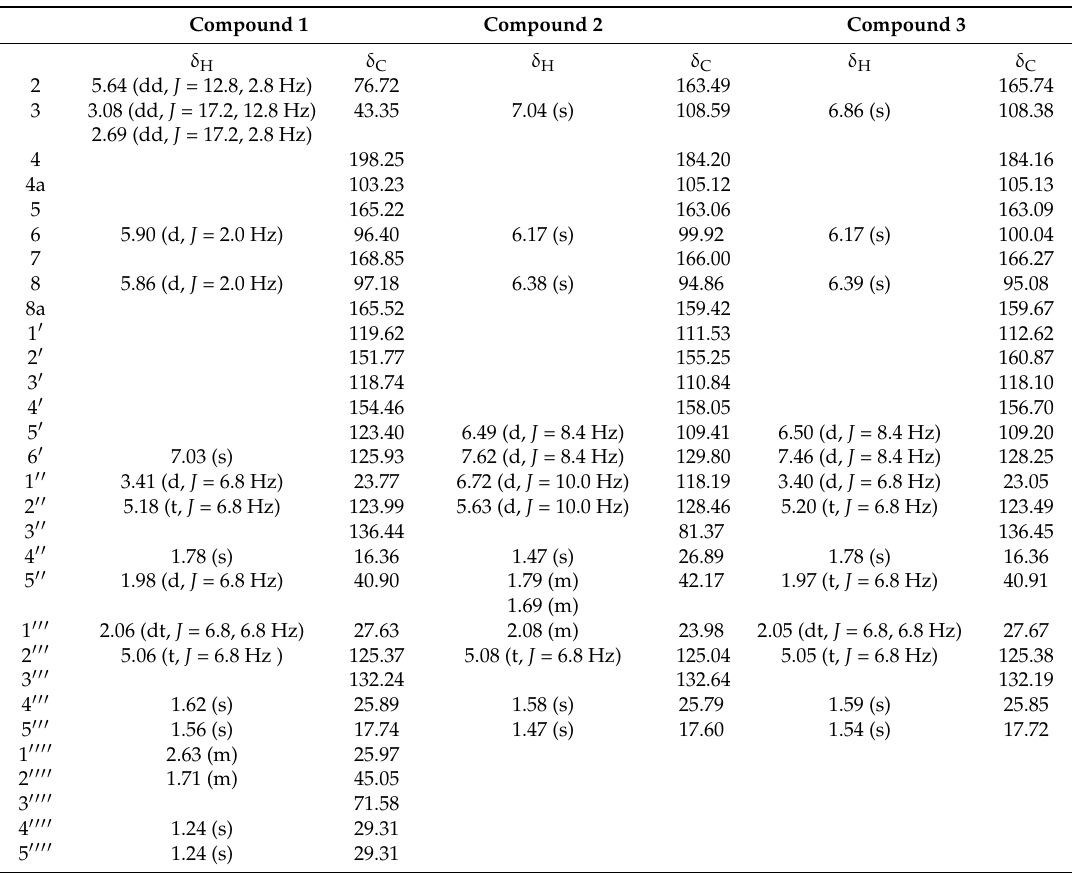
Table 1. 1 H- and 13 C-NMR data (400 and 100 MHz, resp.; CD 3 OD) of isoprenylated flavonoids 1 – 3 from the root bark of Morus alba